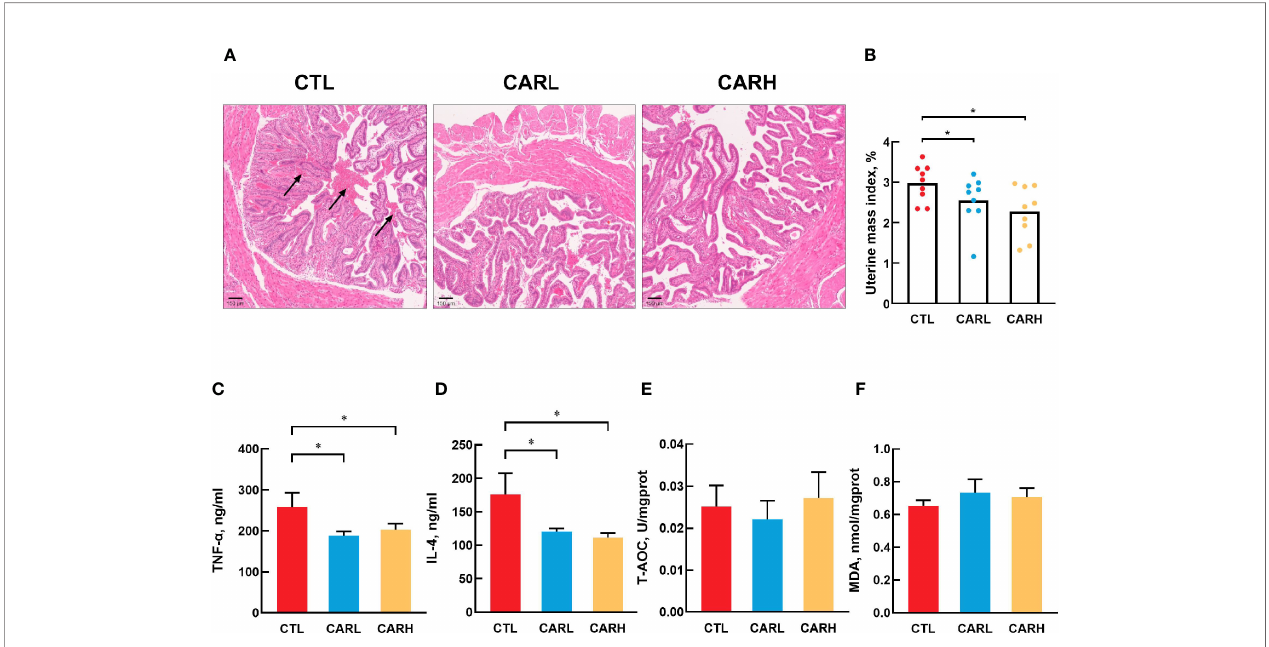
FIGURE 1 | Effect of b -carotene on uterine morphology and serum biomarkers. Representative images of hematoxylin and eosin (H&E) stained uterine section (A) , uterine mass index=uterine mass/body weight (B) , serum TNF- a (C) , IL-4 (D) concentration, total antioxidant capacity of liver (E) , MDA content (F) . CTL, a basal diet; CARL, a basal diet containing 30 mg/kg b -carotene; CARH, a basal diet containing 90 mg/kg b -carotene. Data were shown as means ± SD (n = 9). * P < 0.05.